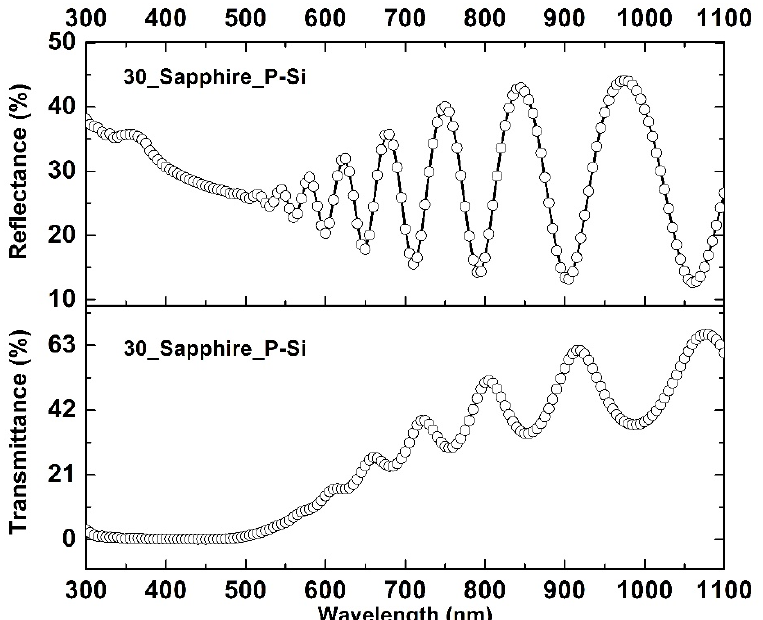
Figure 4. Reflectance spectrum of boron-doped p-type polycrystalline silicon film on sapphire (Al 2 O 3 ) substrates. Transmission spectrum of boron-doped p-type polycrystalline silicon film on sapphire (Al 2 O 3 ) substrates.